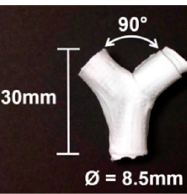
Figure 21. Vascular Y-graft produced by electrospinning, with a the 2-DOF positioning system and an internal electrical field collector approach.